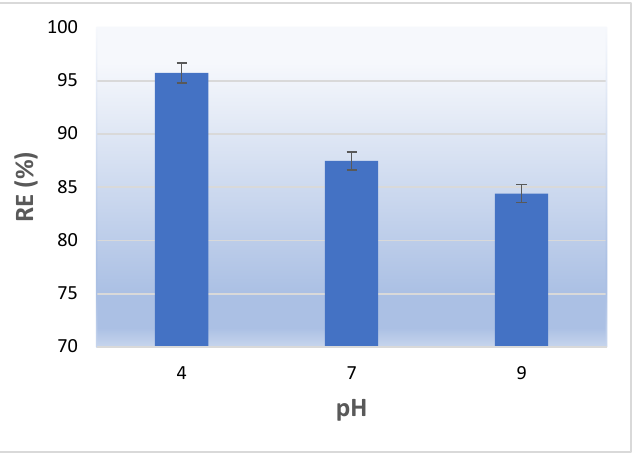
Figure 11. Effect of pH on the dye removal efficiency (m = 0.01 g, C 0 = 50 mg L −1 , V = 10 mL, T = 298 K, and time = 48 h).